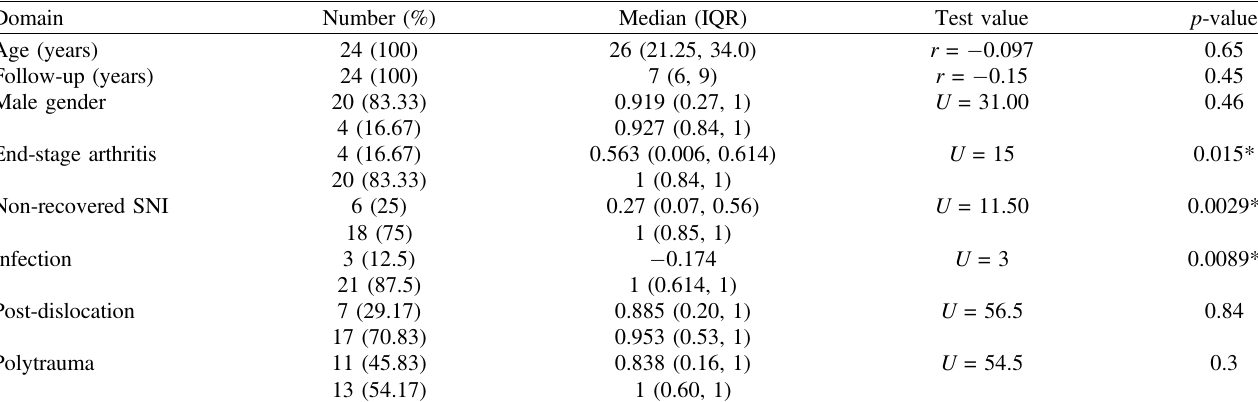
Table 2. Factors affecting the EQ-5D value index at fi nal follow-up.